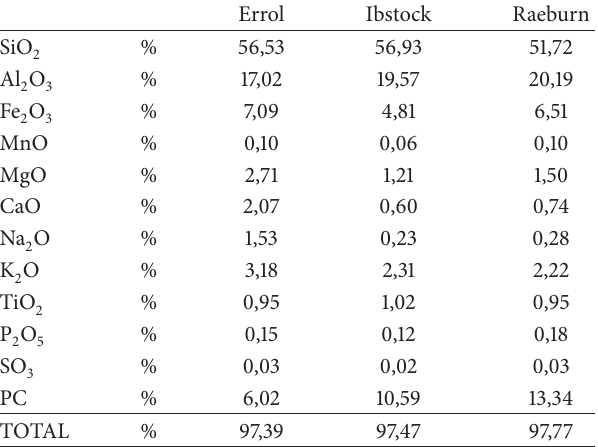
Figure 4: XRD patterns of the Raeburn soil oriented aggregates. Table 4: Chemical composition of three